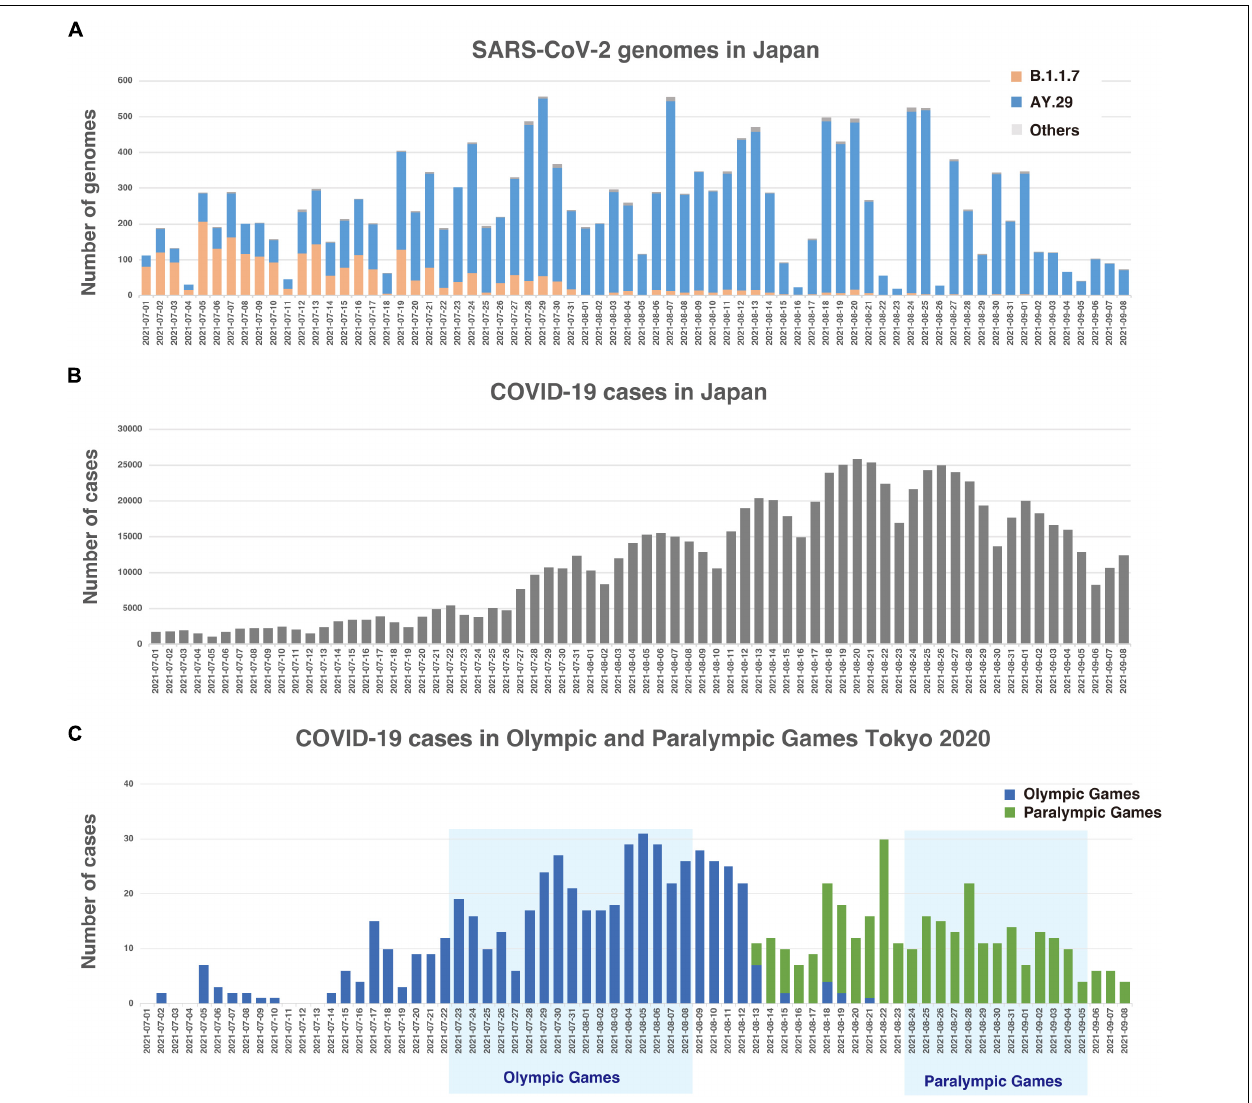
FIGURE 1 | (A) Histogram of strains by lineages in Tokyo. (B) Number of daily new COVID-19 positive cases in Japan. (C) Number of daily new COVID-19 positive cases among Olympic and Paralympic participants.